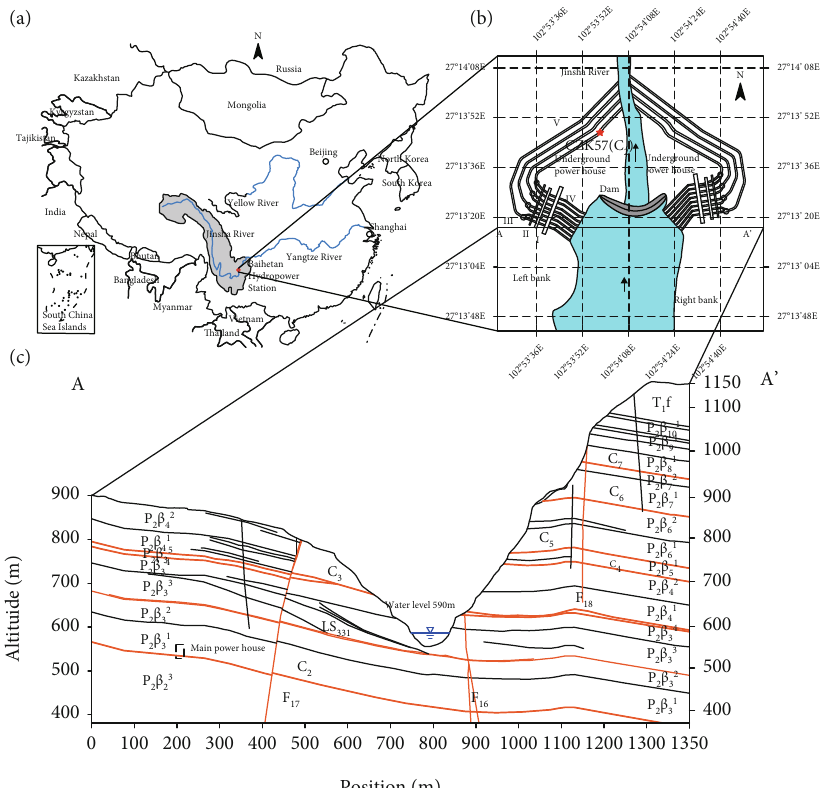
Figure 3: The location of the Baihetan hydropower station and the test sites. (a) Geographical location map of Baihetan hydropower station in China. (b) The layout of hydropower station and the distribution of the test sites. (c) The spatial distribution of main hydrogeological structures (sections A-A ’